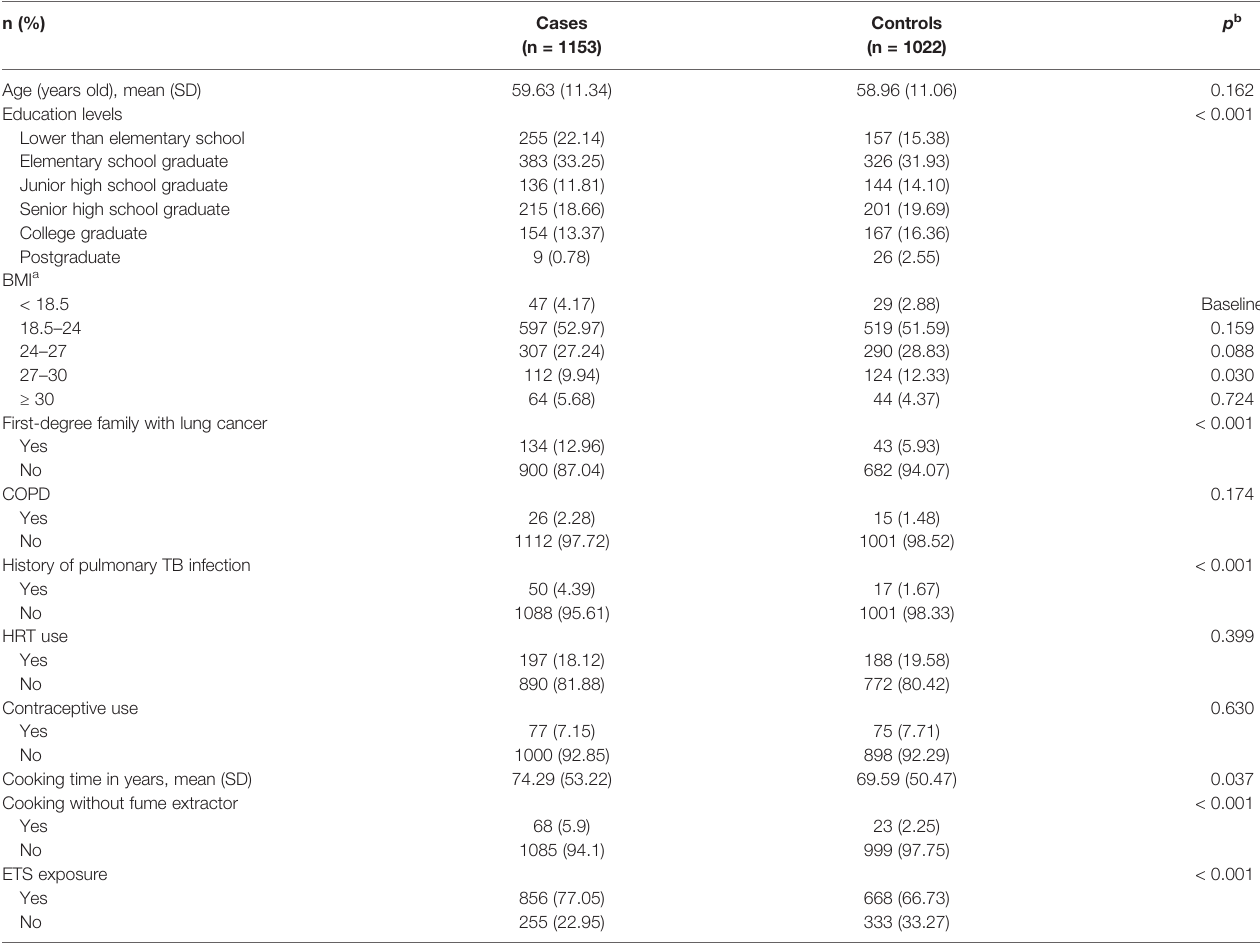
TABLE 1 | Clinical characteristics of lung adenocarcinoma patients and healthy controls. n